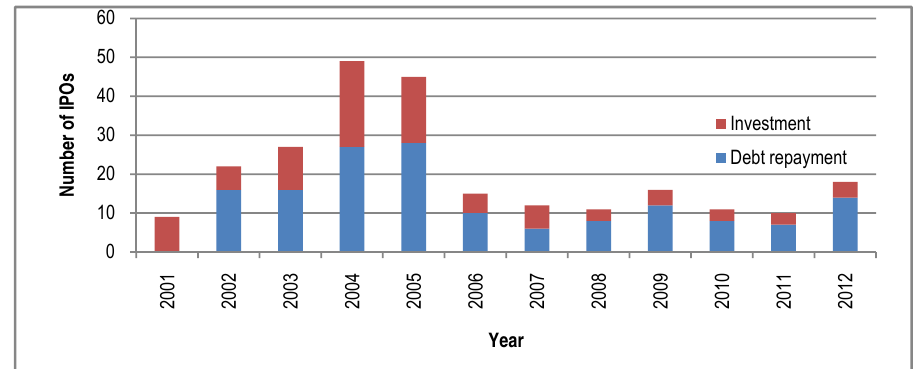
Fig. 1. Initial Public Offerings (IPOs) with intended use of the proceeds in Thailand between 2001 and